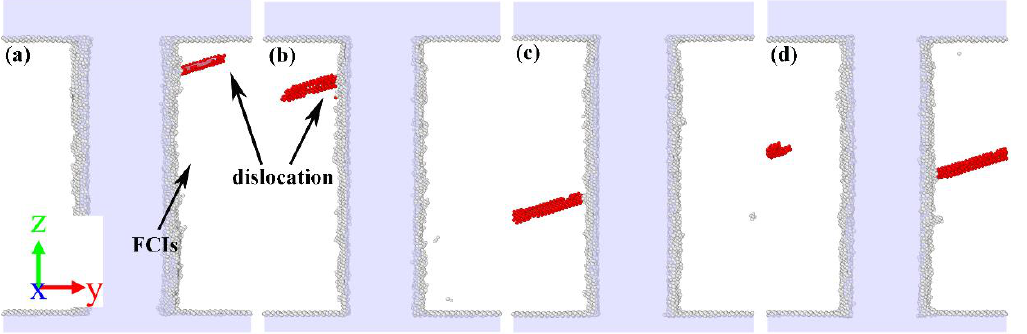
Figure 7. Atomic configurations for the dislocation nucleation of ( a ) Fe2C model, ( b ) Fe3C model, ( c ) Fe4C model, and ( d ) Fe7C3 model. The red atoms are the stacking fault atoms, and the white atoms are the disordered atoms at FCIs and boundary.